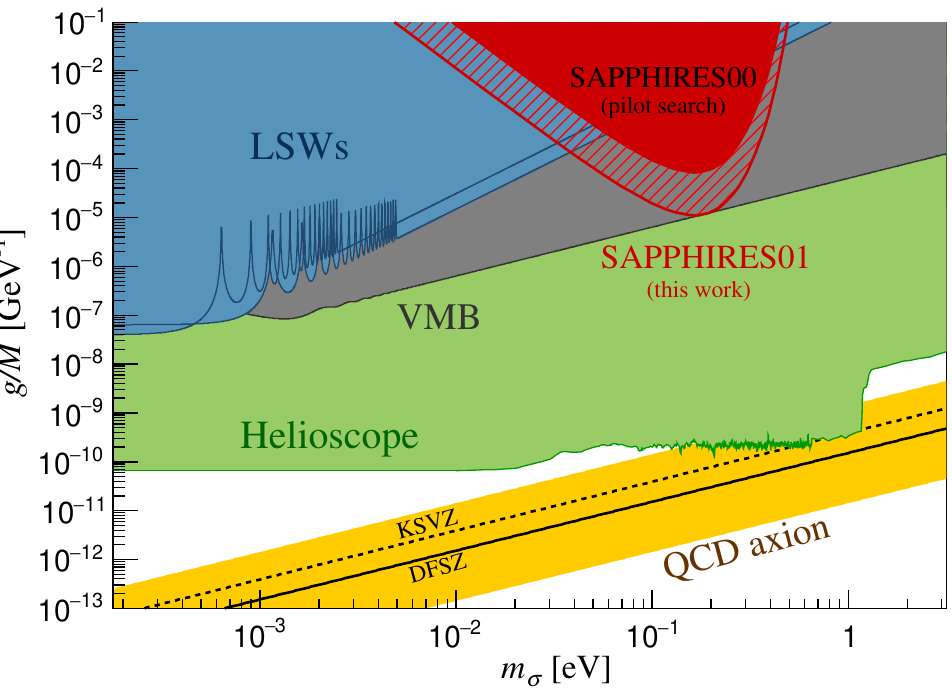
Figure 12 . Upper limit in the m σ − g/M parameter space for pseudoscalar field exchanges achieved in this work, SAPPHIRES01, represented by the red shaded area. The red filled area is from the pilot search, SAPPHIRES00 [11]. Limits from the LSW experiments (ALPS [7] and OSQAR [9]), the VMB experiment (PVLAS [10]), and a Helioscope experiment (CAST [18–21]) are shown with the blue, gray, and green filled areas, respectively. The yellow band and the black dashed lines represent QCD axion predictions from the KSVZ model [22, 23] with 0 . 07 < | E/N − 1 . 95 | < 7 and E/N = 0 , respectively. The solid line is the prediction from the DFSZ [24, 25] model with E/N = 8 / 3